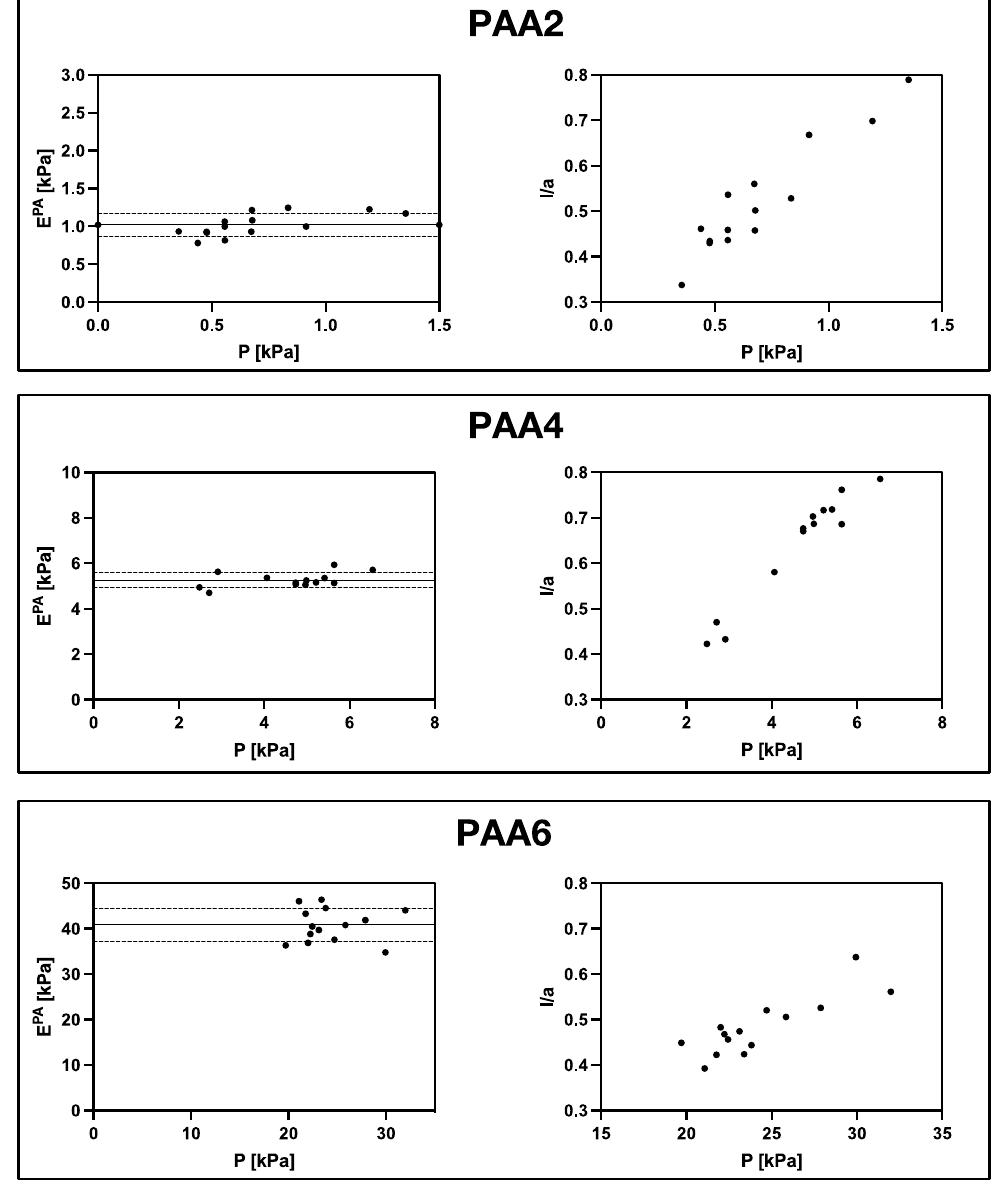
Figure 6. Elastic moduli of different PAA hydrogels measured by pipette aspiration test performed for different pressures. Data for three hydrogels are reported as example, relative to low, medium and high stiffness. Measurable l/a values are mostly > 0.3, to avoid large reading errors. The graphs indicate that calculated moduli are substantially constant with applied pressure. The lines in the figure on the left represent the mean value of E PA and the standard